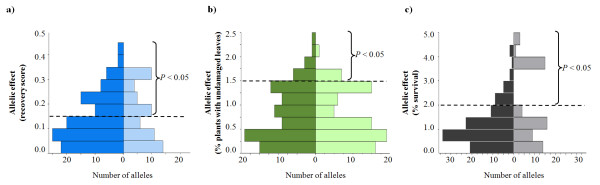
Distribution of allelic effects (βSNP) of SNP - frost tolerance associations in a) controlled, b) semi-controlled, and c) field platforms. The left and right hand side bars in a), b) and c) represent alleles with negative and positive effects relative to the Lo152 reference allele, respectively. The significance threshold (P < 0.05) for each platform is indicated by a dashed line.